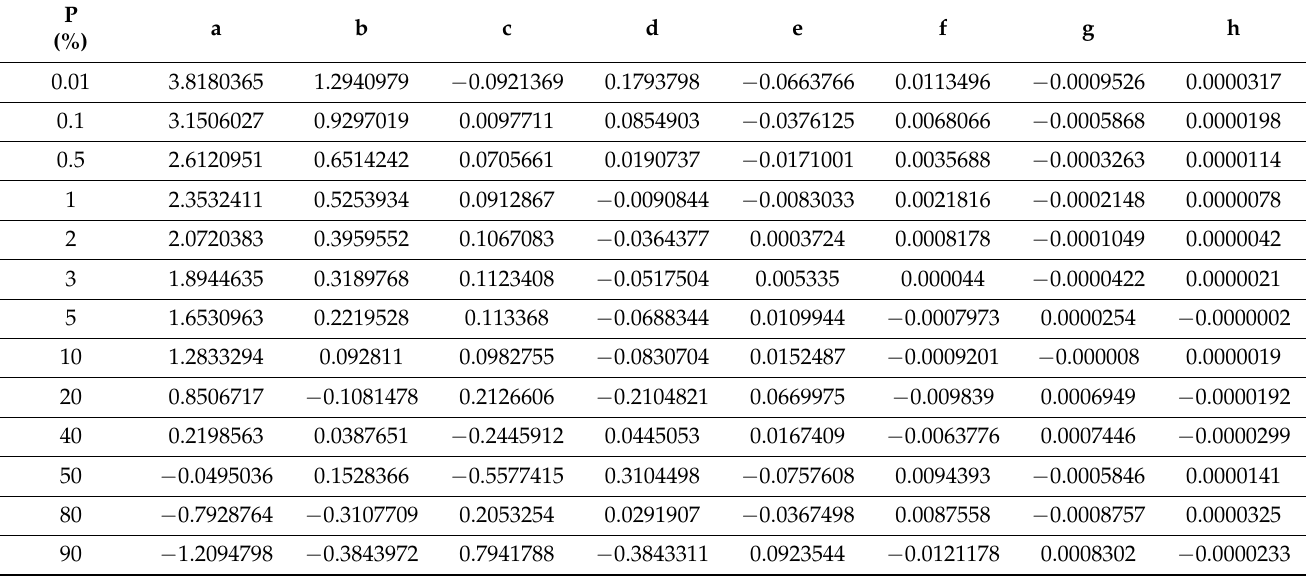
Table A8. The frequency factor for estimation with MOM for chi.